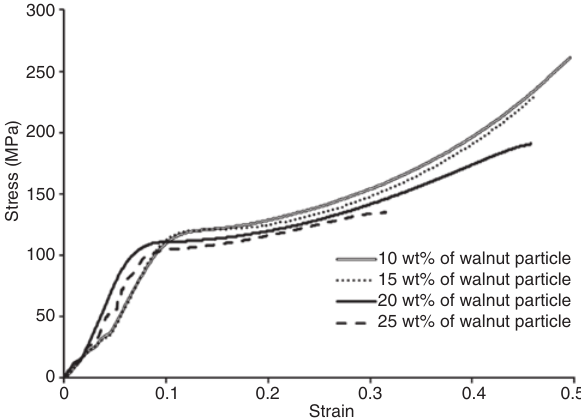
Figure 4 Stress-strain diagram under compression for different wt% of walnut particles.